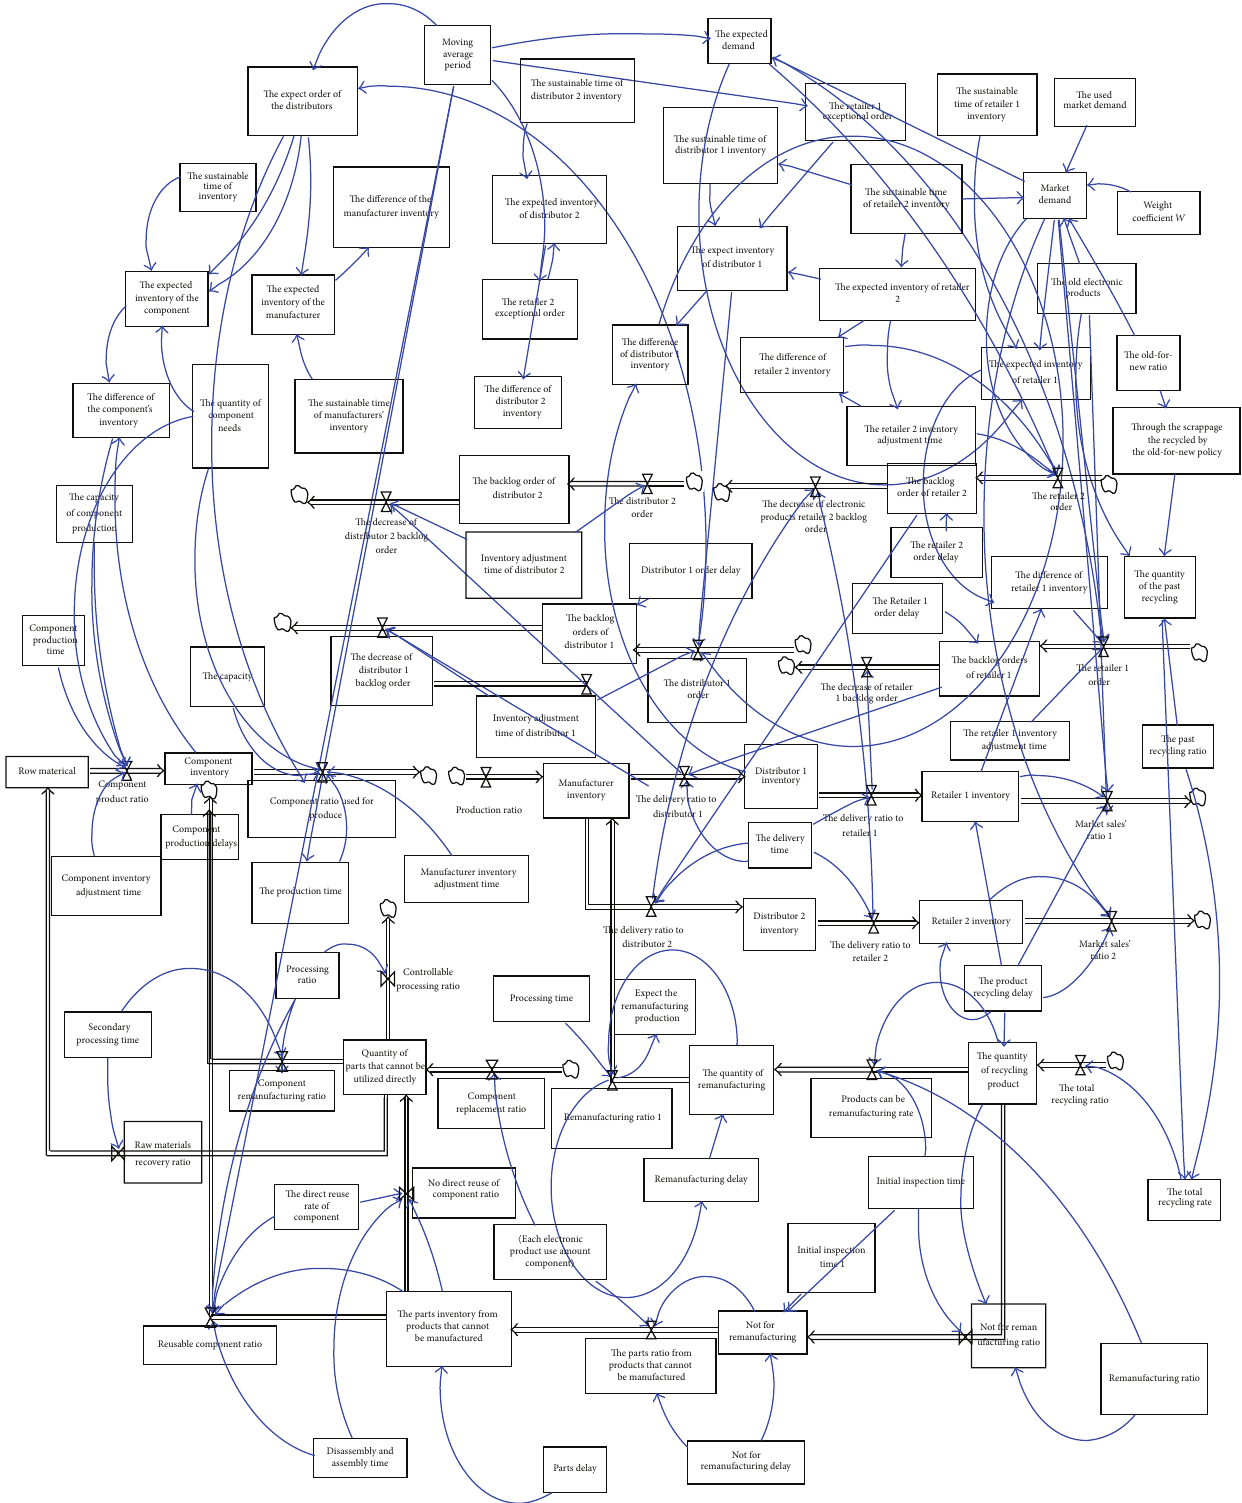
Figure 2: The electronic products closed-loop supply chain distribution network system dynamics flow